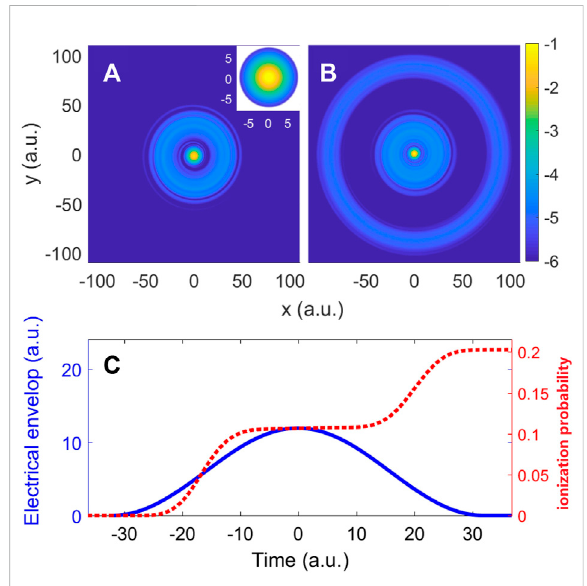
FIGURE 4 (Coloronline)Probabilitydensityofelectroninthemiddle( t = 0) and at the end ( t = 32) of a circularly polarized laser pulse in panels (A,B) . The initial ground state is plotted as the inset of panel (A) . Panel (C) is the time-dependent instantaneous ionization probability(reddashedline)ofthegroundstateofhydrogenatoms inthepresenceofalaserpulse.Theelectricalenvelopeofthelaser pulse and the blue solid line are plotted. All parameters are the same as those in Figure 3C, except the peak intensity I 0 = 5 × 10 18 W/cm 2